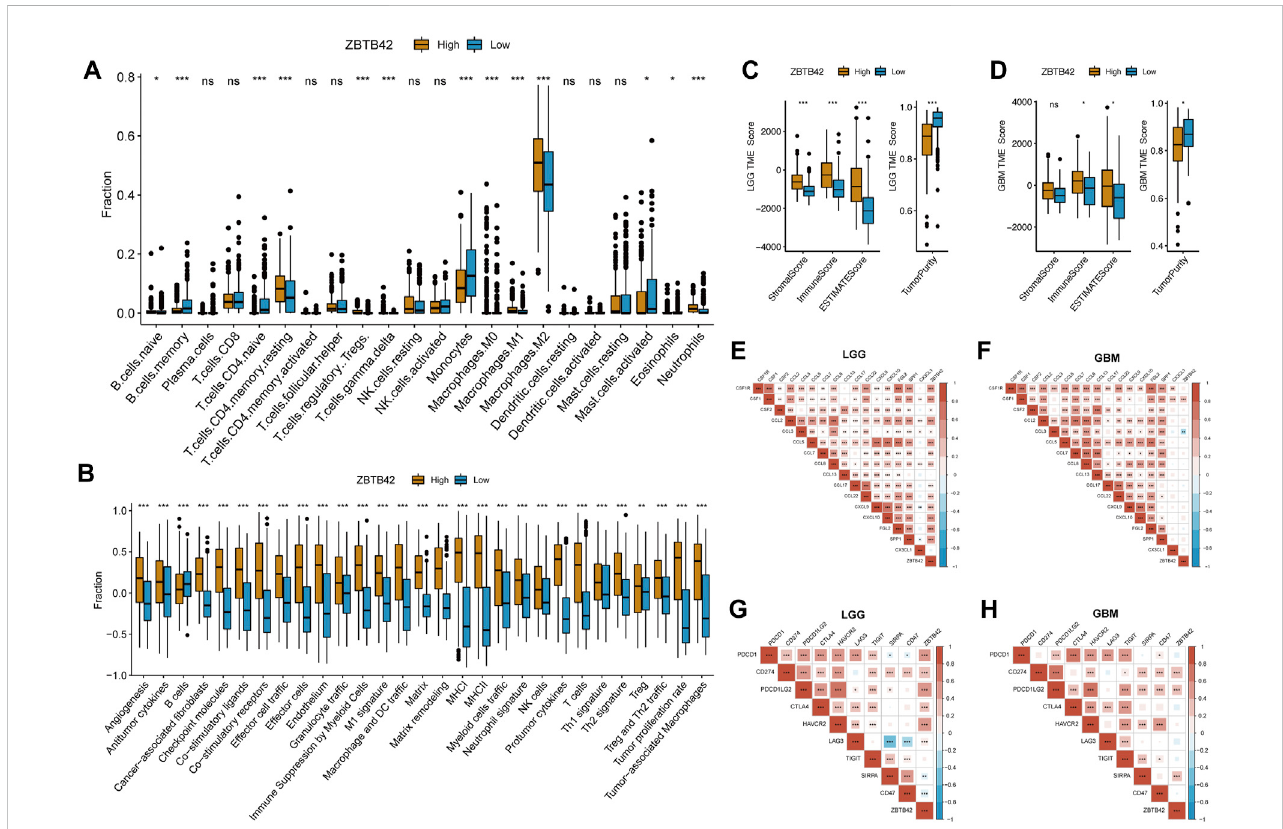
FIGURE 5 High ZBTB42 expression group is associated with immune suppression in glioma. (A) The fraction of 22 immune cell in fi ltration in high ZBTB42 expression group and low expression group of gliomas. (B) Immune-related signature scores between high ZBTB42 expression group and low expression group of gliomas by ssGSEA analysis. (C,D) Stromal score, Immune score, and ESTIMATE score, and tumor purity of LGG (C) and GBM (D) in the TCGA dataset. (E – H) Map of ZBTB42 correlation with cytokine genes, chemokine genes, and immune checkpoint genes in LGG (E, G) and GBM (F, H)